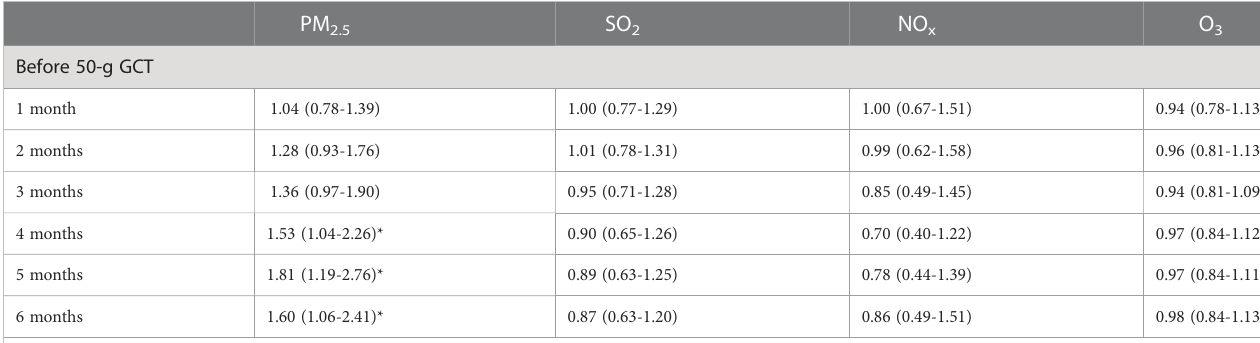
TABLE 4 Associations between mean concentrations of air pollutants during a de fi ned period and GDM a . PM 2.5 SO 2 NO x O 3 Before 50-g GCT